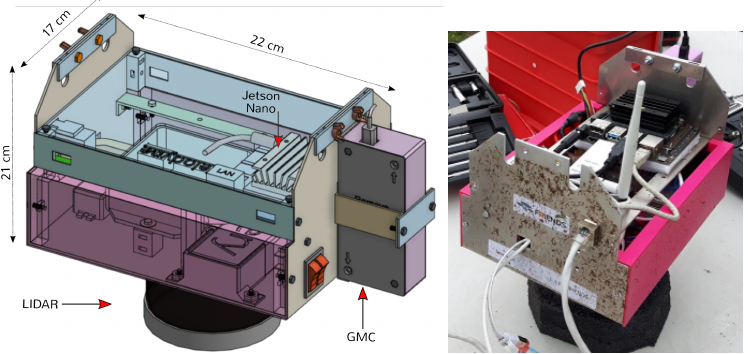
Figure 14. Sensorbox: CAD model ( left image) and photo of the actual Sensorbox without lids ( right